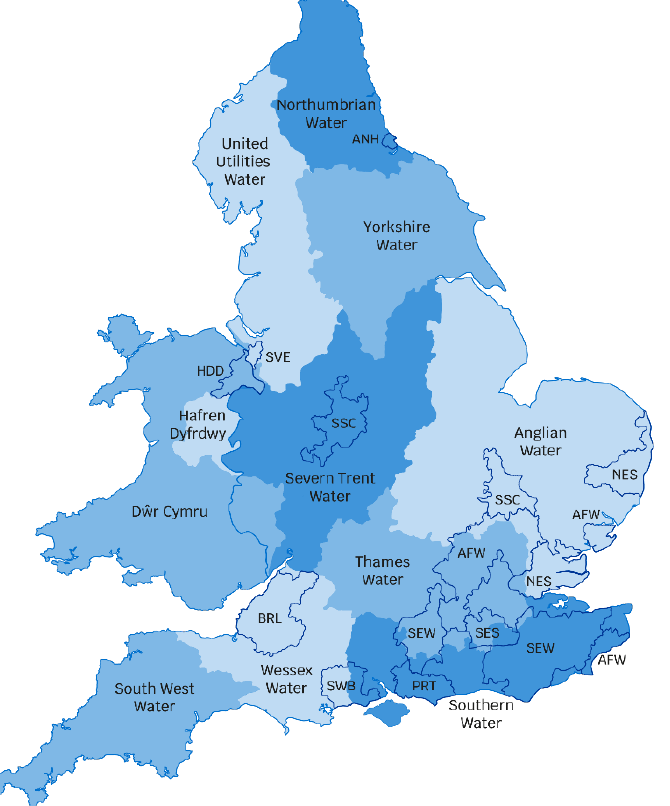
Figure 1. Areas serviced by water and sewerage companies in England and Wales. The present assessment is based on storm overflow data reported by South West Water, Wessex Water, Southern Water, Anglian Water and United Utilities. Source: Ofwat [29]. Key for abbreviated company names is available at: https://www.ofwat.gov.uk/households/your-water-company/contact-companies/ [accessed on 12 September 2022]